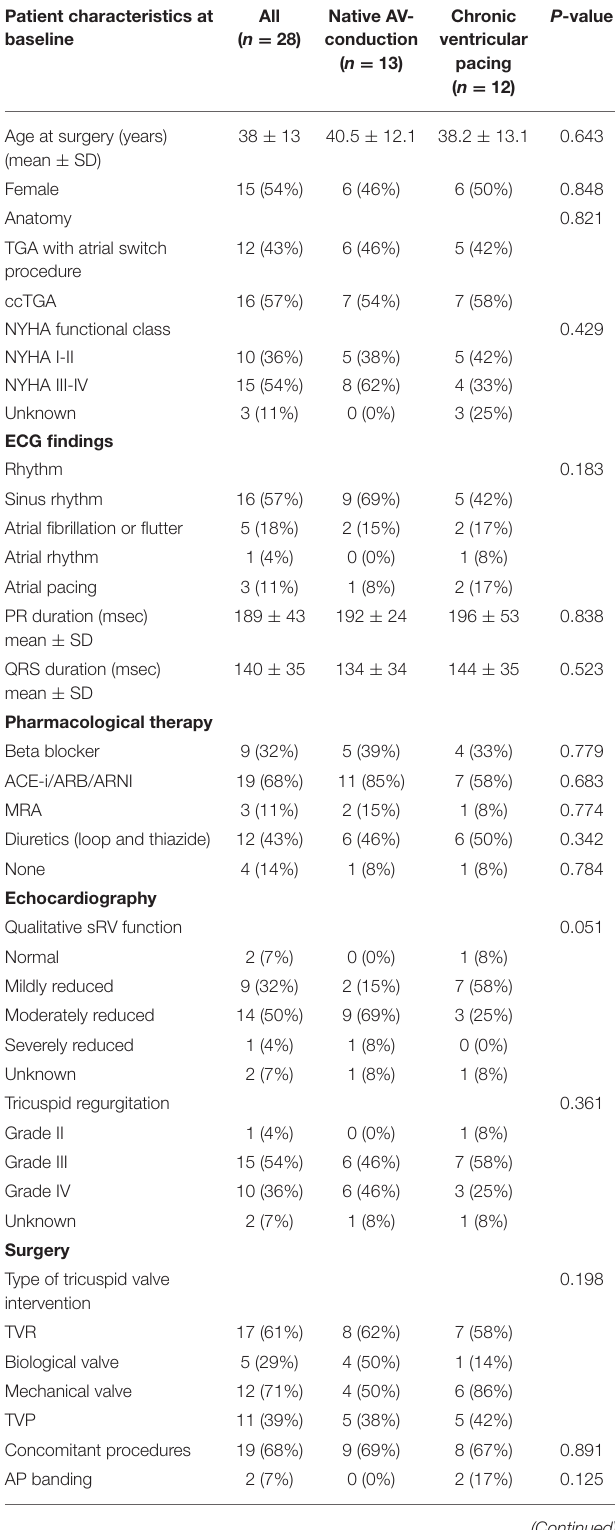
TABLE 1 | Patient characteristics at baseline and patient characteristics compared between the group that retains native atrioventricular (AV)-conduction and the group that develops high-degree